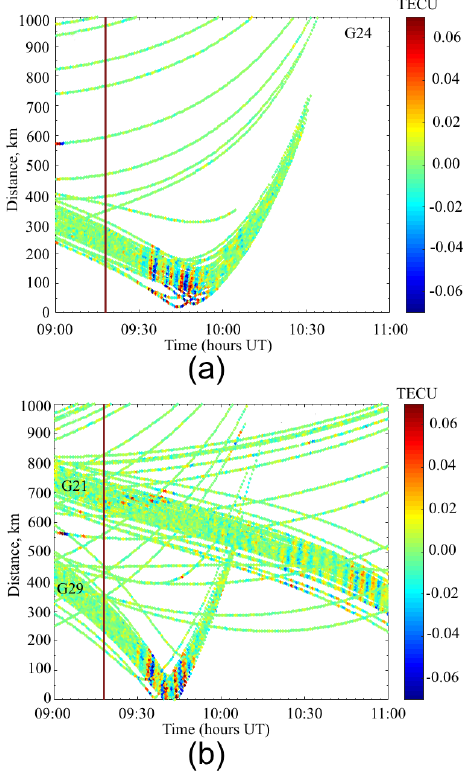
Figure 12. The traveltime diagram plotted within the time span 09:00 − 11:00 UT on 15 June 2009 by using ( a ) satellite G24 and ( b ) satellites G21, G29. It shows the most prominent CVIDs in the near-field (0 – 200km) and far-field zone (300 – 600km) with respect to the volcano. The vertical red solid line indicates the explosion time. Color represents the appropriate TEC amplitude.